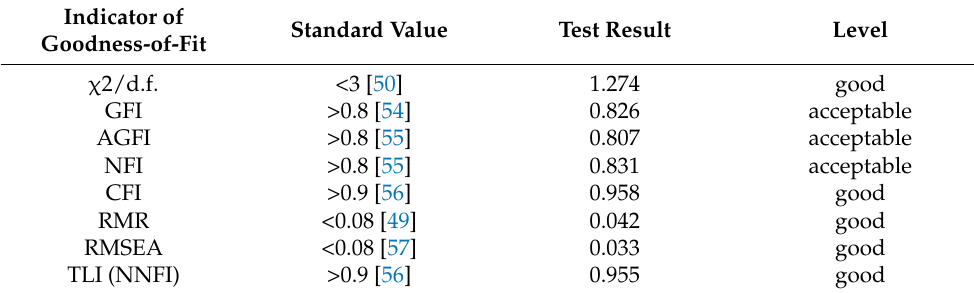
Table 5. Overall fits of research model.